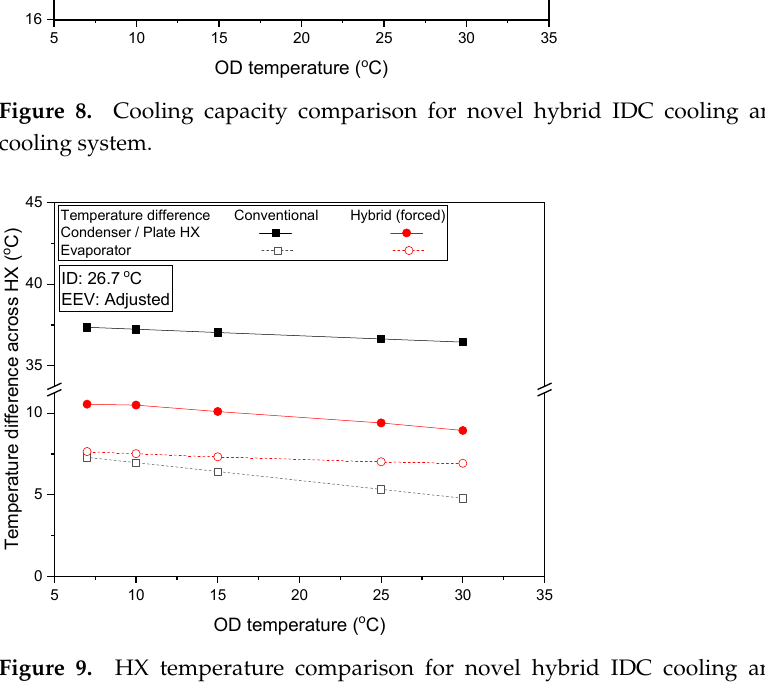
Figure 10. Saturation temperature comparison for novel hybrid IDC cooling and conventional IDC cooling system. 5